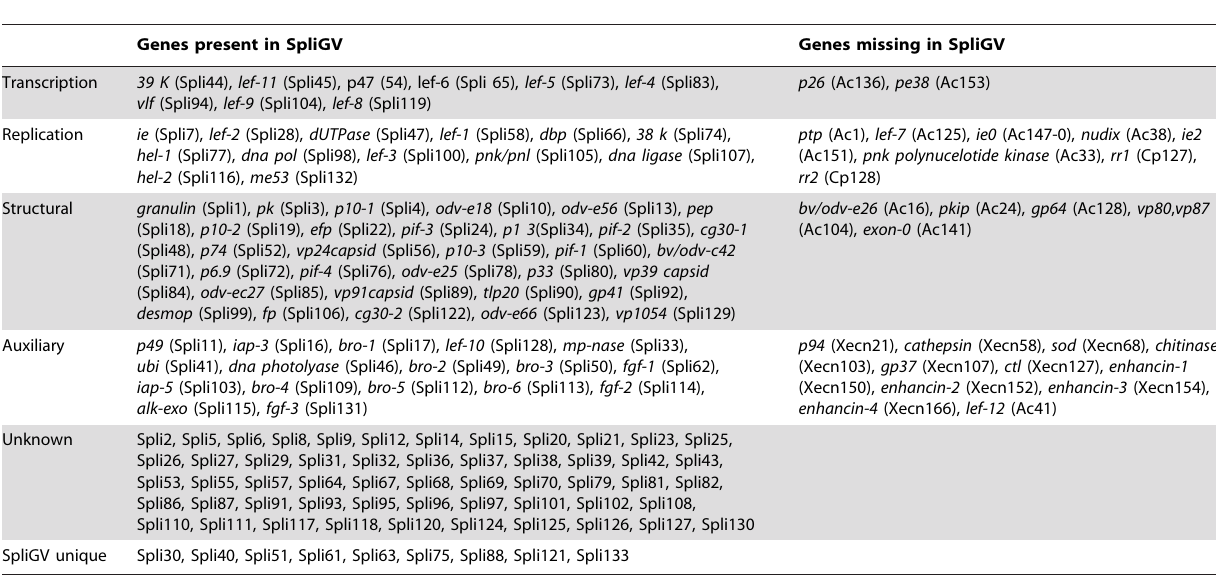
Table 2. SpliGV genes grouped according to functional comparison with other baculoviruses.